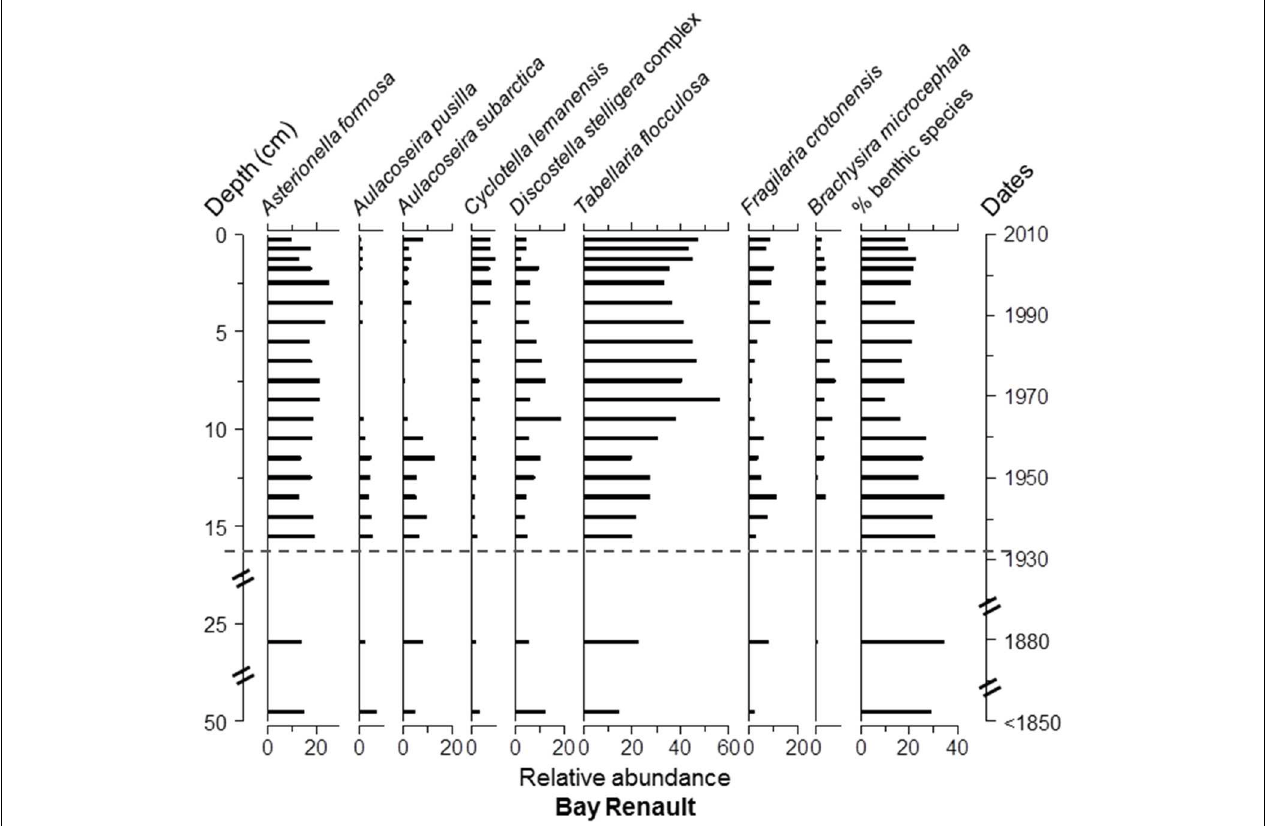
FIGURE 7 | Diatom taxa paleolimnological profiles represented as % abundance in the benthic sediments of Bay Renault. The dotted line corresponds to the pre-mining period based on sedimentation rates determined with 210 Pb data.